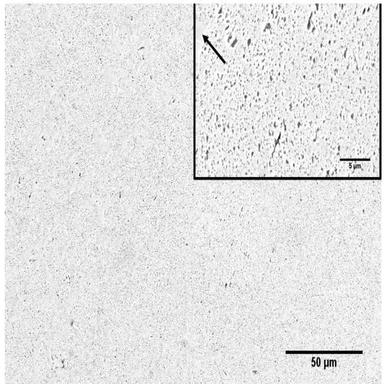
Structure of the SPS_Cu3B sample involves nano/submicron-sized boron phase distributed in the copper matrix. The inset shows the structure at a higher magnification. The arrow shows a small boron-free region.